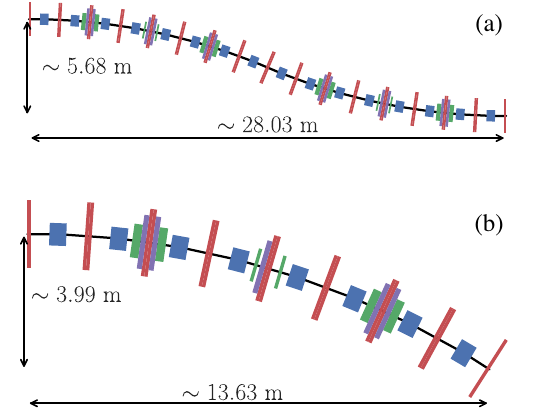
FIG. 11. The geometry of the bunch compressors BC1 (a) and BC2 (b), where red, blue, green, and purple rectangles are quadrupoles, dipoles, sextupoles, and octupoles magnets,